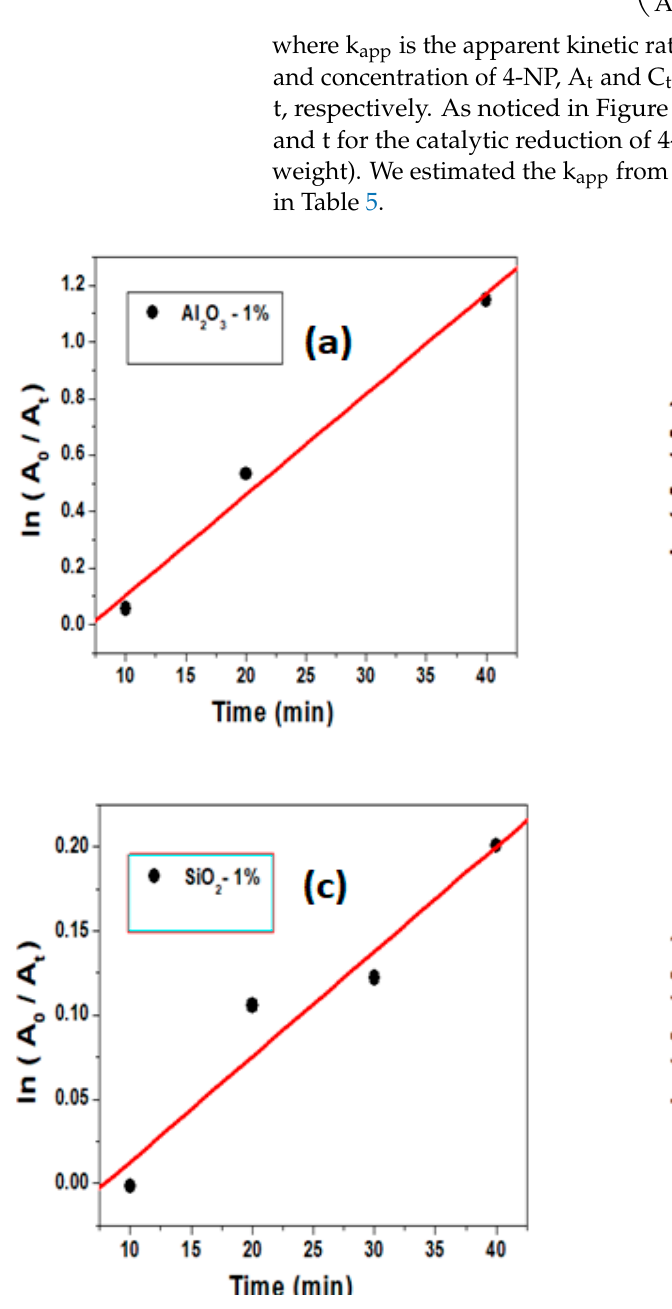
Figure 5. Kinetic plots of ln (A 0 /A t ) versus time for the catalytic reduction of 4-NP in the presence of ( a ) 1% Al 2 O 3 NF, ( b ) 2% Al 2 O 3 NF, ( c ) 1% SiO 2 NF and ( d ) 2% SiO 2 NF.